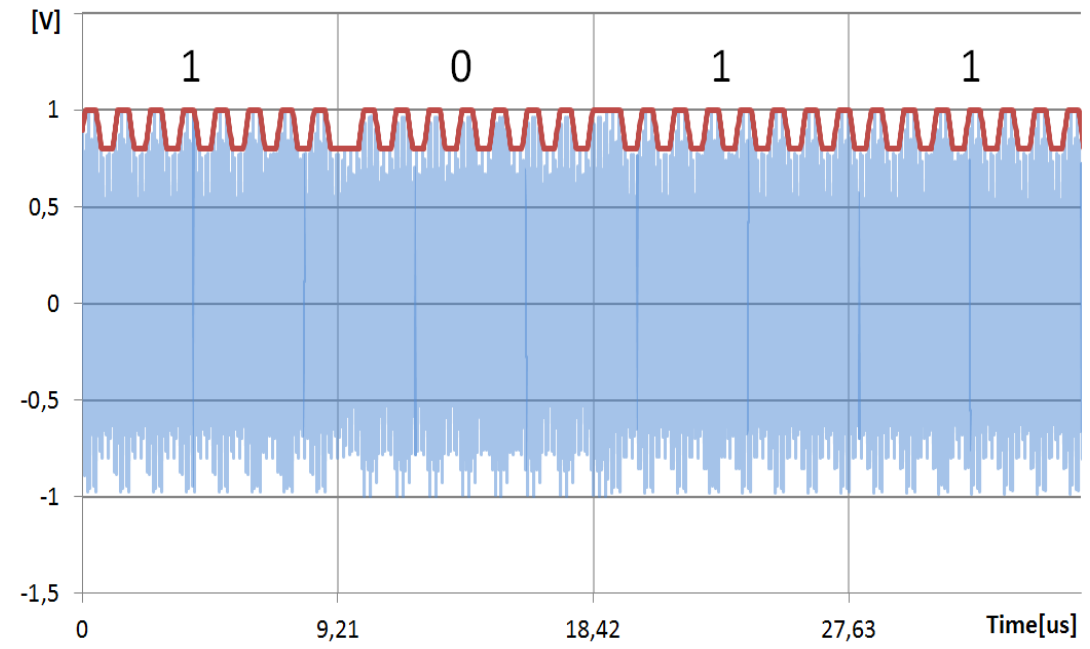
Figure 3. Principle of the BPSK modulation scheme. The load modulated subcarrier (0.8475 MHz) is 180° phase shifted according to the bitstream for PICC to PID